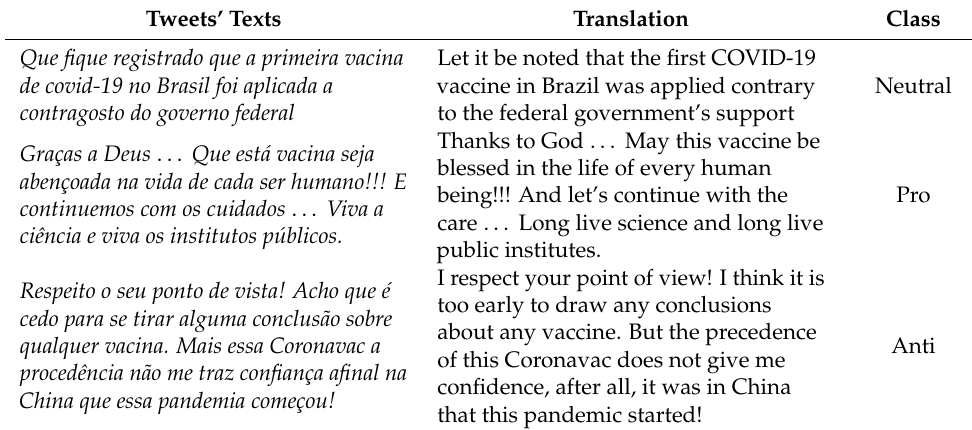
Table 5. Examples of tweets’ texts from 17 January 2021.